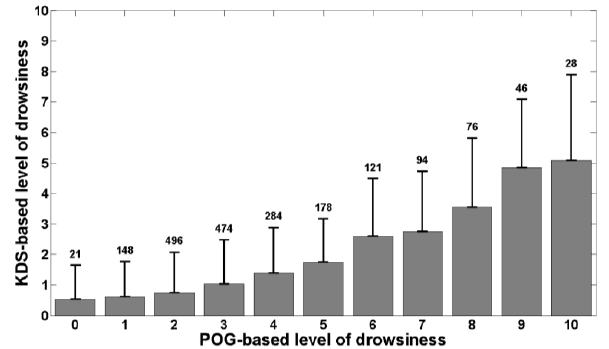
Figure 2. KDS-based level of drowsiness as a function of POG-based level of drowsiness. Each bin represents the mean KDS-based level of drowsiness for each value of POG-based level of drowsiness. The error bars show the standard deviation around each mean value and the number above each bin indicates the number of 20-s windows falling into the bin.